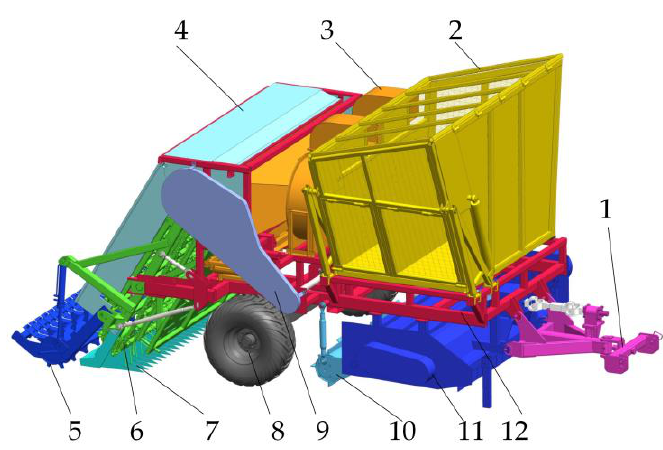
Figure 1. Overall structure diagram of SRPFC. Note: 1 — Linkage; 2 — Collecting box; 3 — SIRD; 4 — Cover plate; 5 — Crushing device; 6 — FCCH; 7 — Film lifting device; 8 — Traveling system; 9 — Transmission device; 10 — Film cutting device; 11 — Straw crushing and returning device; 12 — Rack.